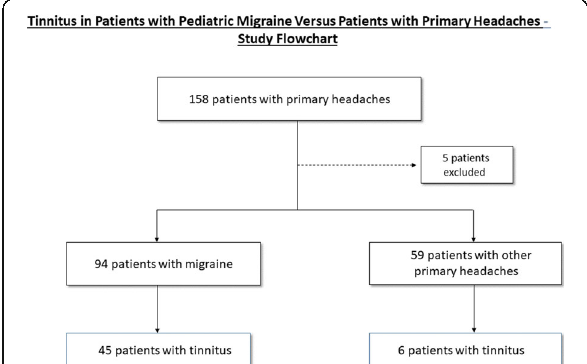
Fig. 2 (abstract P163). See text for